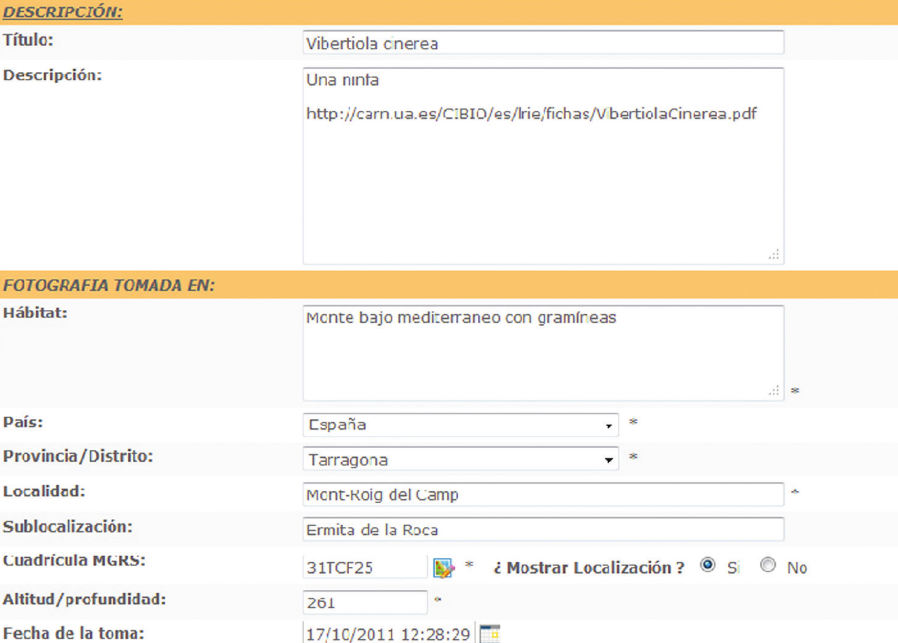
Figure 2. Fields to be filled when uploading pictures to Biodiversidad Virtual internet photosharing website. An asterisk (*) states for obligatory